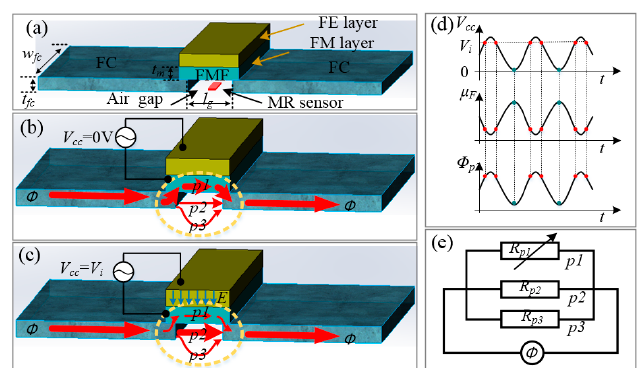
Figure 1. ( a ) Illustration of the prototype magnetic sensor: the schemata for magnetic flux through the three paths around the air gap for ( b ) V cc = 0 and ( c ) V cc = V i (a voltage value closed to the V max ); ( d ) the schemata of the modulation principle: permeability of FMF µ F and magnetic flux through air gap Φ p2 derived by an alternating-current (AC) voltage V cc loaded at FE layer; ( e ) equivalent magnetic circuit model. FE, ferroelectric; FM, ferromagnetic; FC, flux concentrator; FMF, flux modulation film; MR, magnetoresistive; V cc , driving voltage; Rp, magnetic reluctance (parts 1, 2, and 3); w fc , and t fc represent width and thickness of FC, respectively